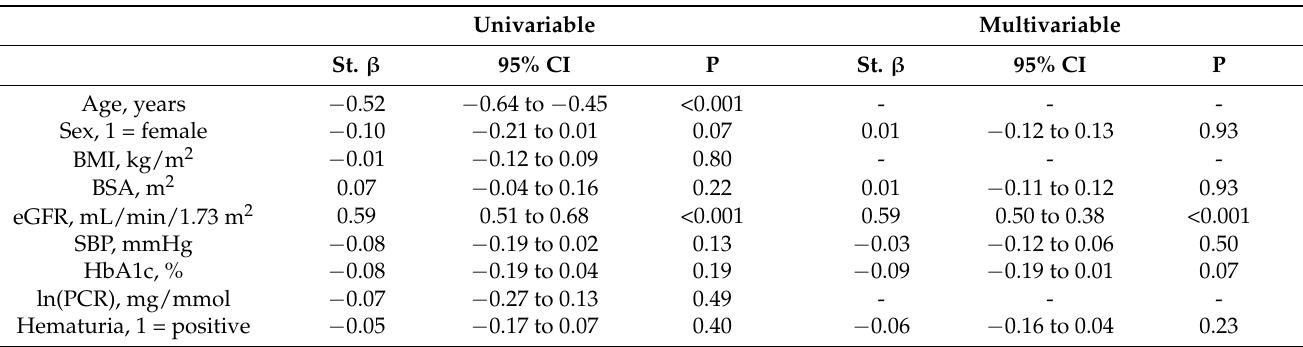
Table 4. Uni- and multivariable linear regression analyses of pre-donation hematuria and other characteristics with five-year post-donation eGFR.